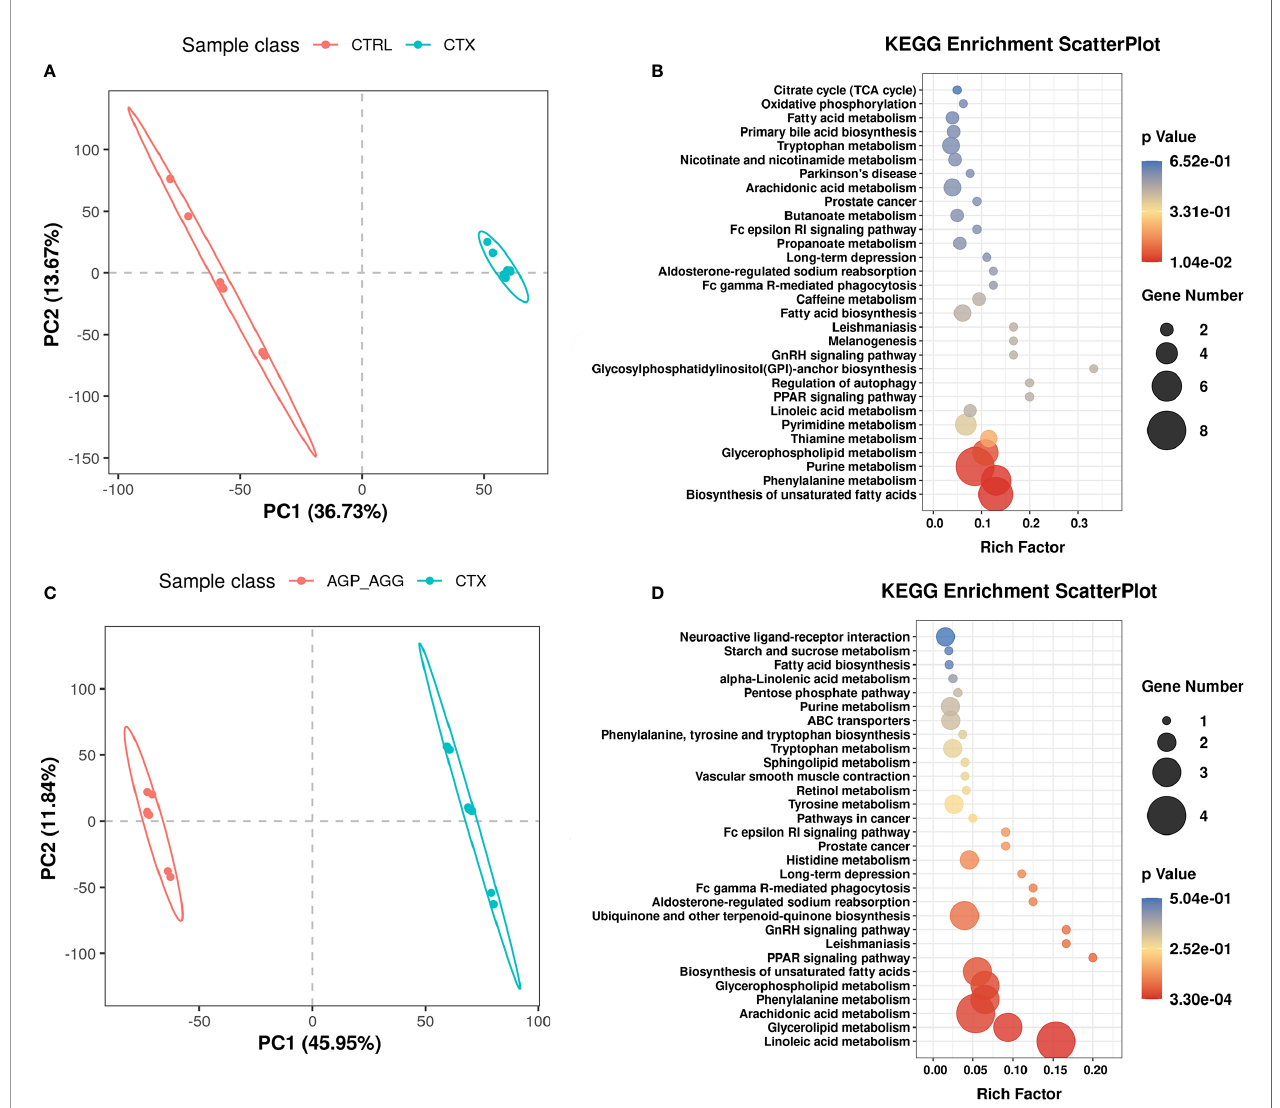
FIGURE 7 | AG treatments alters fecal metabolites in CTX-induced mice. (n=7 for each group). (A) OPLS-DA score plots from CTRL group vs CTX group. (B) Pathway Enrichment based on altered metabolites from CTRL group vs CTX group. (C) OPLS-DA score plots from AGP_AGG group vs CTX group. (D) Pathway Enrichment based on altered metabolites between AGP_AGG group and CTX group. CTRL, control group; CTX, cyclophosphamide-induced immunosuppressive group; AGP_AGG, American ginseng polysaccharide+American ginseng ginsenoside with cyclophosphamide-induced immunosuppressive